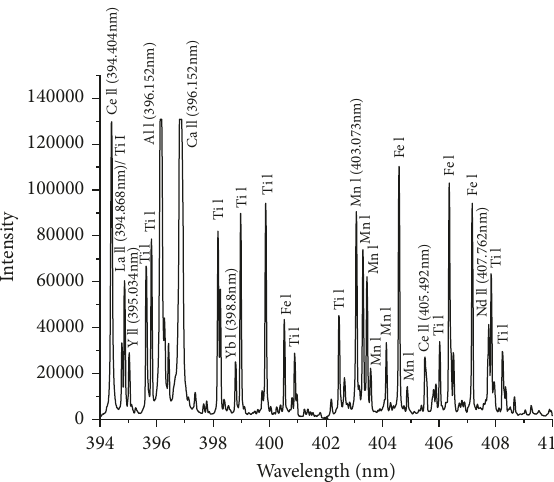
Figure 12: SP-LIBS spectrum for monazite sands along with some identified lines for REEs (adapted from